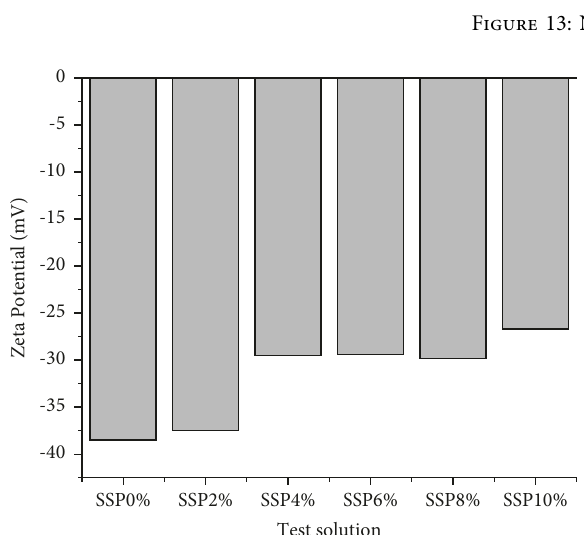
Figure 13: Nucleation process.